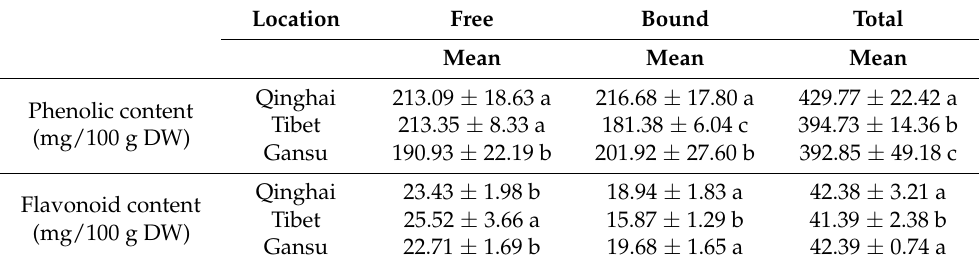
Table 2. Average contents of phenolic and flavonoid of blue highland barley from different